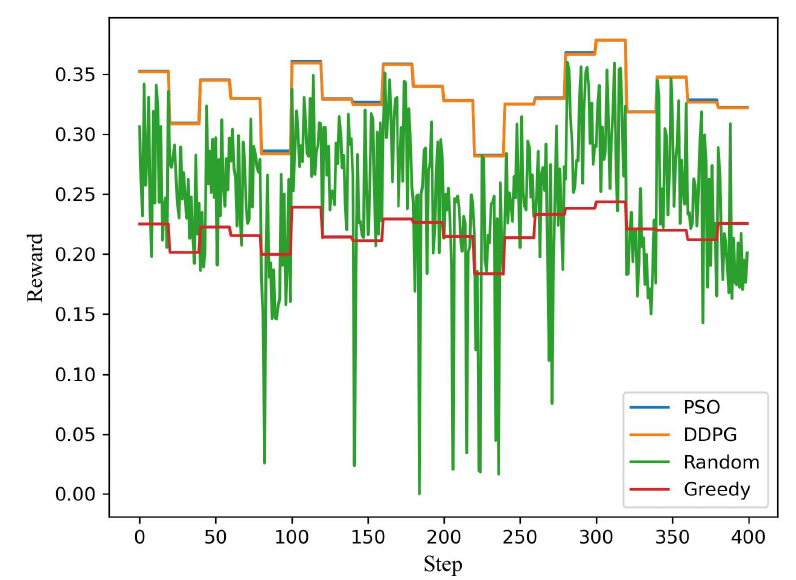
Figure 4. The system reward distance for each step for a pair of